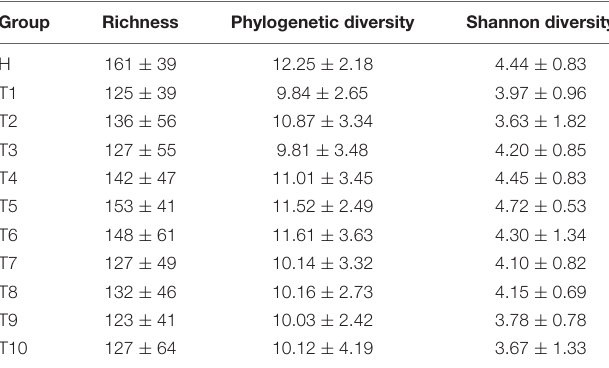
TABLE 2 | The richness, phylogenetic diversity, and Shannon diversity in non-small cell lung cancer patients and healthy individuals. Group Richness Phylogenetic diversity Shannon